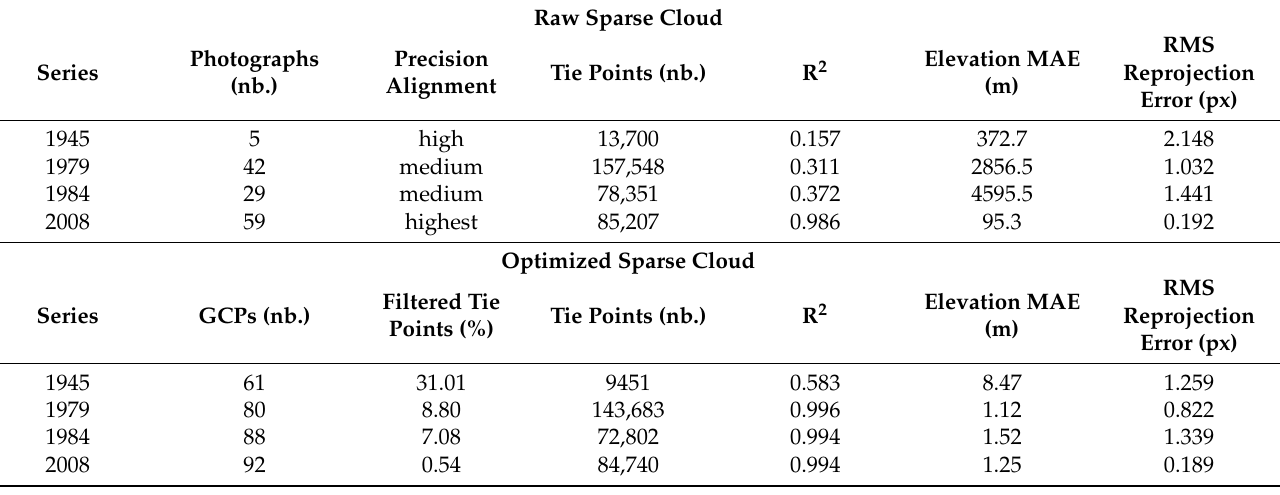
Table 2. Summary of error statistics for the SfM raw and optimized Sparse Clouds. Raw Sparse